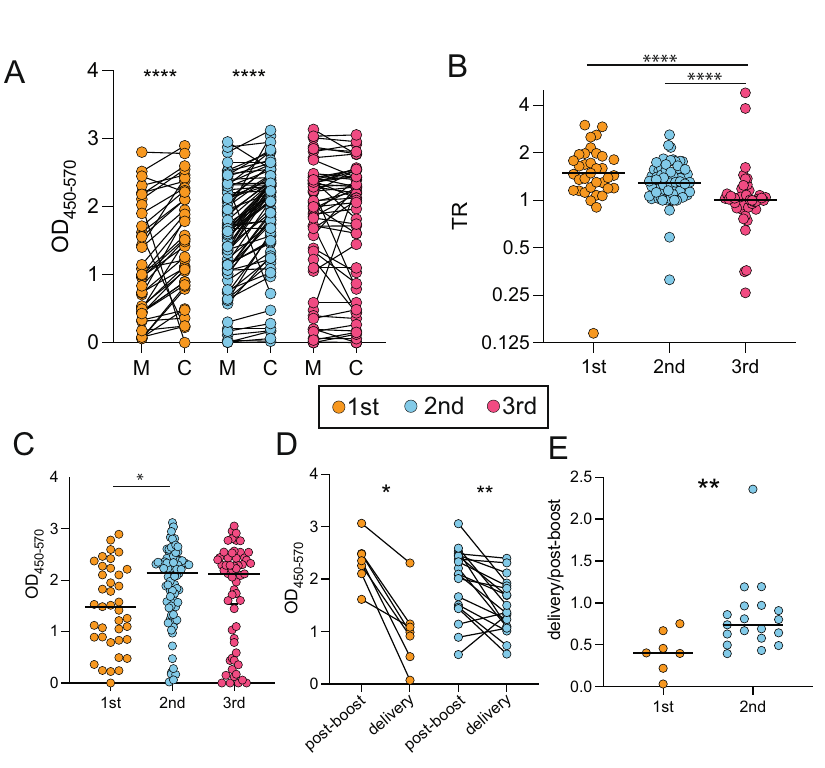
Fig. 5 Transfer ef fi ciency differs by trimester of vaccination. A The dot plots show the Spike-speci fi c IgG titer in maternal (M) or cord (C) plasma. Lines connect paired dyads. The color indicates the trimester of vaccination, fi rst (orange), second (blue) or third (pink). Signi fi cance was determined by a Wilcoxon signed-rank test (2-sided), * p < 0.05, ** p < 0.01, *** p < 0.001, **** p < 0.0001. Exact p -values presented fi rst trimester: p < 0.0001 (GraphPad Prism does not provide a more exact p -value for this comparison), second trimester: p < 0.0001. B The dot plot shows the transfer ratio (cord titer/ maternal titer) of Spike-speci fi c IgG to the cord. Color indicates the trimester of vaccination. Signi fi cance was determined by Kruskal – Wallis test. **** p < 0.0001. The horizontal line represents the group median. Exact p -value 1st vs 3rd TR: p < 0.0001 (GraphPad does not provide any more exact p - value); 2nd vs 3rd p < 0.0001. C The dot plot shows the Spike-speci fi c IgG titer in cord blood by trimester that the mother received COVID-19 vaccination. Signi fi cance was determined by a one-way ANOVA followed by correction for multiple comparisons, * p < 0.05. The horizontal line represents the group median. Exact p -value 1st vs 2nd p = 0.017. D The dot plots show the IgG Spike titer in maternal plasma post-boost (~2 – 6 weeks after the second dose of mRNA vaccine or after a single dose of Ad26.COV2.S vaccine) and at delivery following vaccination in the fi rst (orange) and second (blue) trimester. Lines connect matched samples. Signi fi cance was determined by a Wilcoxon signed-rank test (2-sided), * p < 0.05, ** p < 0.01. Exact p -value 1st p = 0.016. Exact p -value 2nd p = 0.002. E The dot plot shows the ratio of the IgG Spike titer delivery/post-boost following vaccination in the fi rst (orange) and second (blue) trimesters. Signi fi cance was determined by a two-tailed Mann – Whitney test, ** p < 0.01. The horizontal line represents the group median. Exact p - value 1st vs 2nd p = 0.0085. Source data are presented in Source Data File waning of maternal titers was more signi fi cant after fi rst com- These results augment our current understanding of how the pared to second trimester maternal vaccination, and both timing of maternal vaccination impacts both maternal immune maternal and neonatal immunity would likely be boosted by a response and transplacental transfer ef fi ciency. Current clinical third maternal COVID-19 vaccine dose in the third trimester recommendations governing the timing of routinely administered when primary vaccination (or vaccination series) occurs in the vaccines in pregnancy (e.g., in fl uenza vaccine, which is admi- fi rst trimester. nistered during in fl uenza season regardless of trimester, and